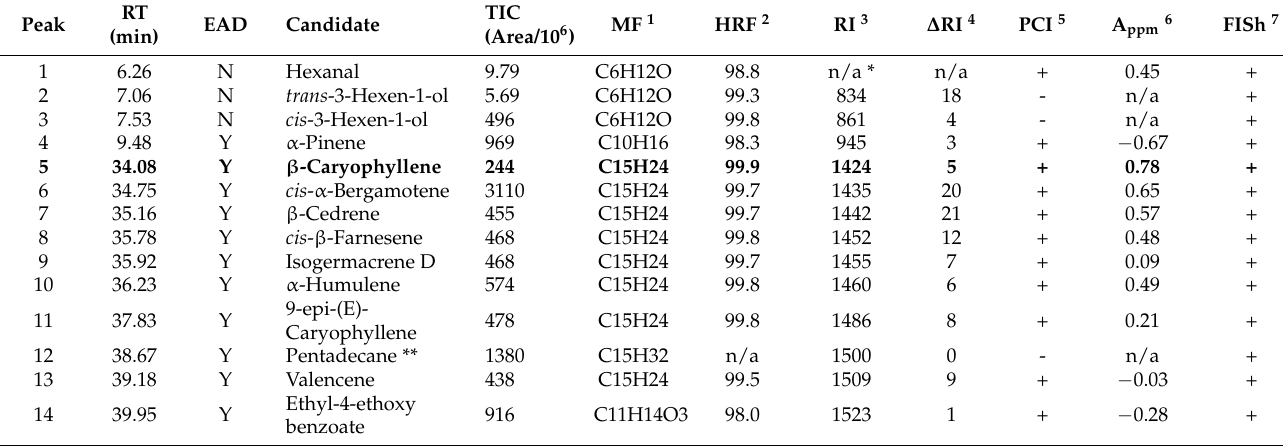
Table 1. Component identification from cracked pomegranate headspace extract by means of GC-Orbitrap MS workflow. RT Peak